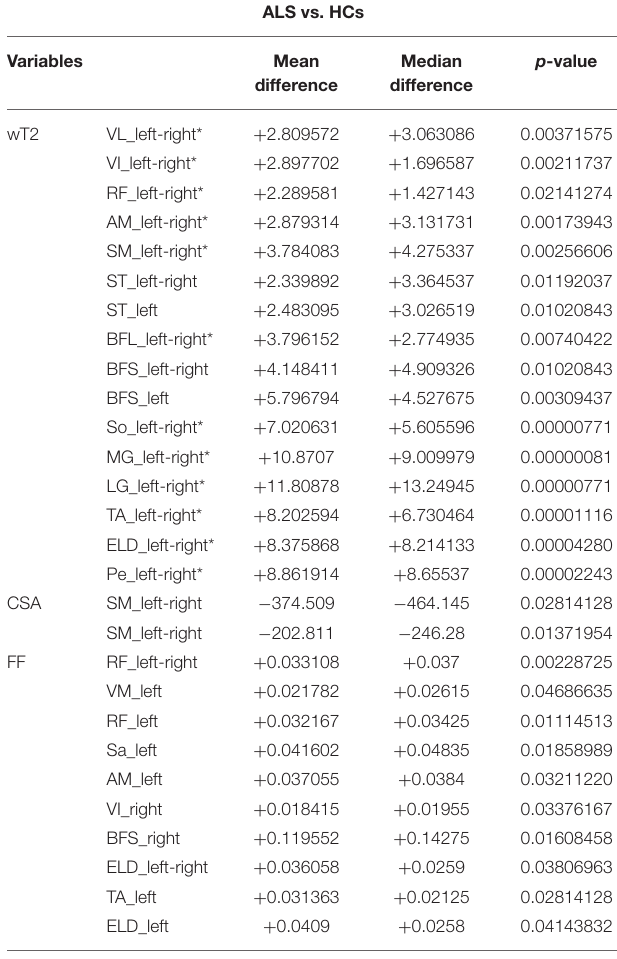
TABLE 2 | Differences in w-T2, CSA and FF between ALS patients and healthy control at baseline. ALS vs.